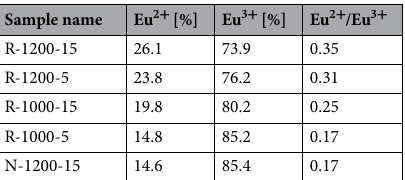
2 + 3 + Table 3. Eu to Eu ratio calculated from XPS